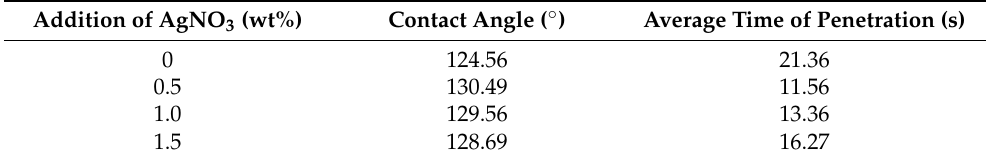
Figure 9. Contact angle and average penetration time of the AgNPs-PS/PET nanofiber membrane at different addition of AgNO 3. Table 3. Effect on the unidirectional liquid transport of AgNPs-PS/PET nanofiber membrane with different addition of AgNO 3.